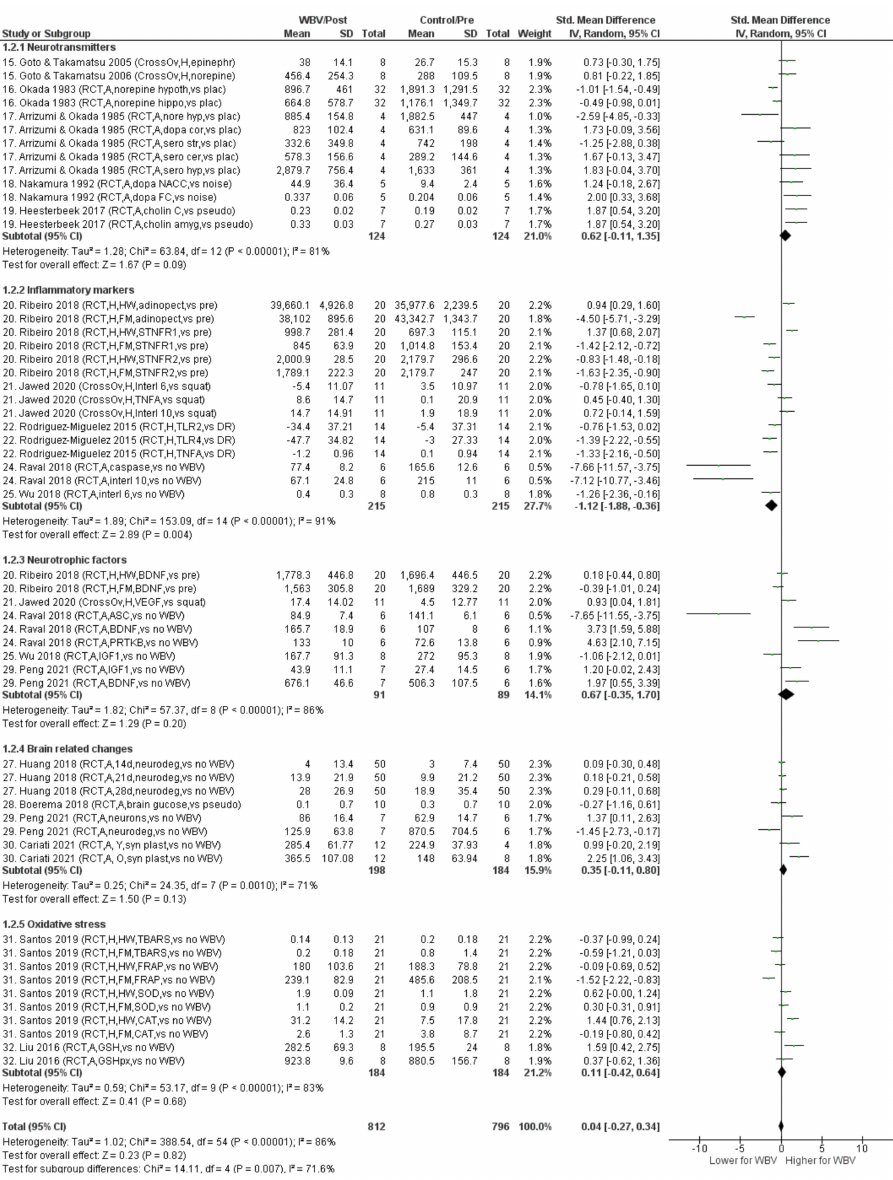
Figure 4. Forest plot with Hedges’ g effect sizes and 95% confidence intervals for the specified outcome measures regarding neuropathological PD mechanisms in non-PD populations (research question 2). Abbreviations: RCT = randomized controlled trial; CrossOv = cross-over design; H = human study; A = animal study; Epinephr = epinephrine; Norepine, Nore = norepinephrine; Hypoth, Hyp = hypothalamus; Hippo = hippocampus; Dopa = dopamine; Cor,C = cortex; Sero = serotonine; STR = striatum; Cer = cerebellum; NACC = nucleus accumbens; FC = frontal cortex; Cholin = cholinergic system activity; Amyg = amygdala; Pseudo = pseudo WBV; HW = healthy women; FM = women with fibromyalgia; Adinopect = adinopectine; STNFR1 = soluble tumor necrosis factor receptor-1; STNFR2 = soluble tumor necrosis factor receptor-2; Interl 6 = interleukin- 6; TNFA = tumor necrosis factor alpha; Interl 10 = interleukin 10; TLR2 = toll-like receptor 2; DR = daily routine; TLR4 = toll-like receptor 4; BDNF = brain derived neurotrophic factor; VEGF = vascular endothelial growth factor; ASC = adipose derived stem cells; PRTKB = phospho- receptor tyrosine kinase; IGF1 = insulin-like growth factor-1; Neurodeg = neurodegeneration; Syn plast = synaptic plasticity; Y = young; O = old; TBARS = thiobarbituric acid reactive substances; FRAP = ferric reducing ability of plasma; SOD = superoxide dismutase antioxidant enzymes activity; CAT = catalase; GSH =